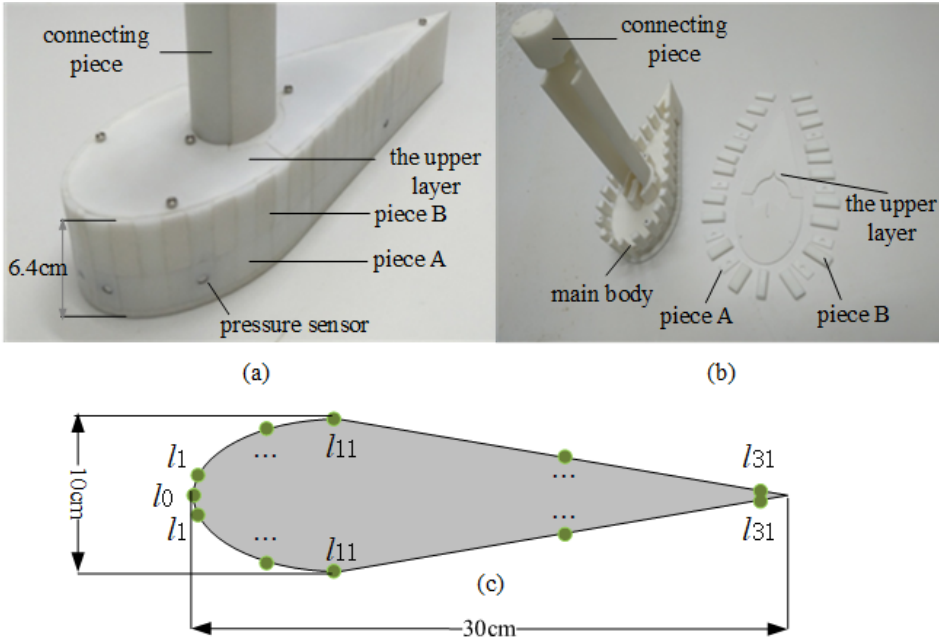
Figure 1. ( a ) Overall appearance of robotic fish. ( b ) Component of the robotic fish. ( c ) Top view of the distribution of pressure sensors on the robotic